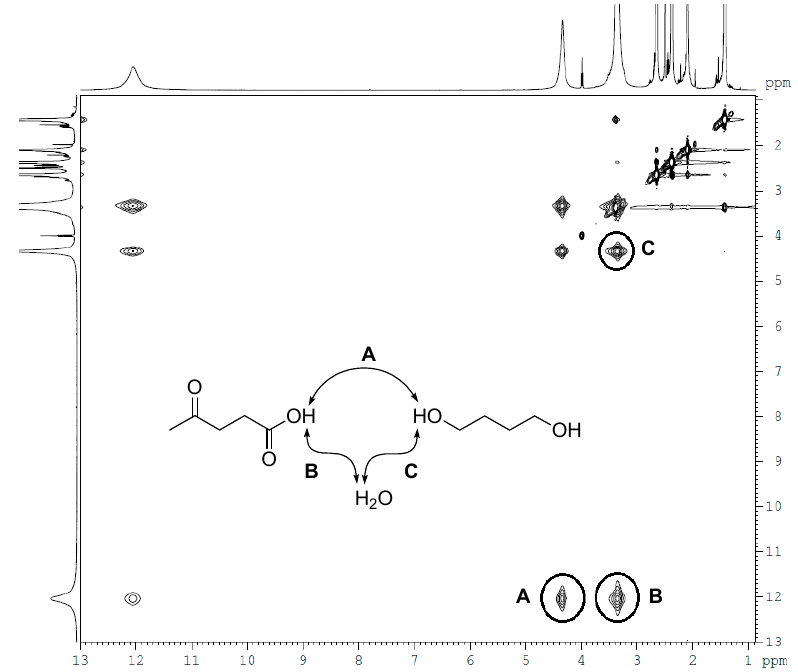
Figure 3. NOESY spectrum of La-Buta DES. ( A ) correlation between the protons on the carboxyl group of La, and the hydroxyl group of Buta; ( B ) correlation between the protons on the carboxyl group of La and water, and; ( C ) correlation between the protons on the hydroxyl group of Buta and water.